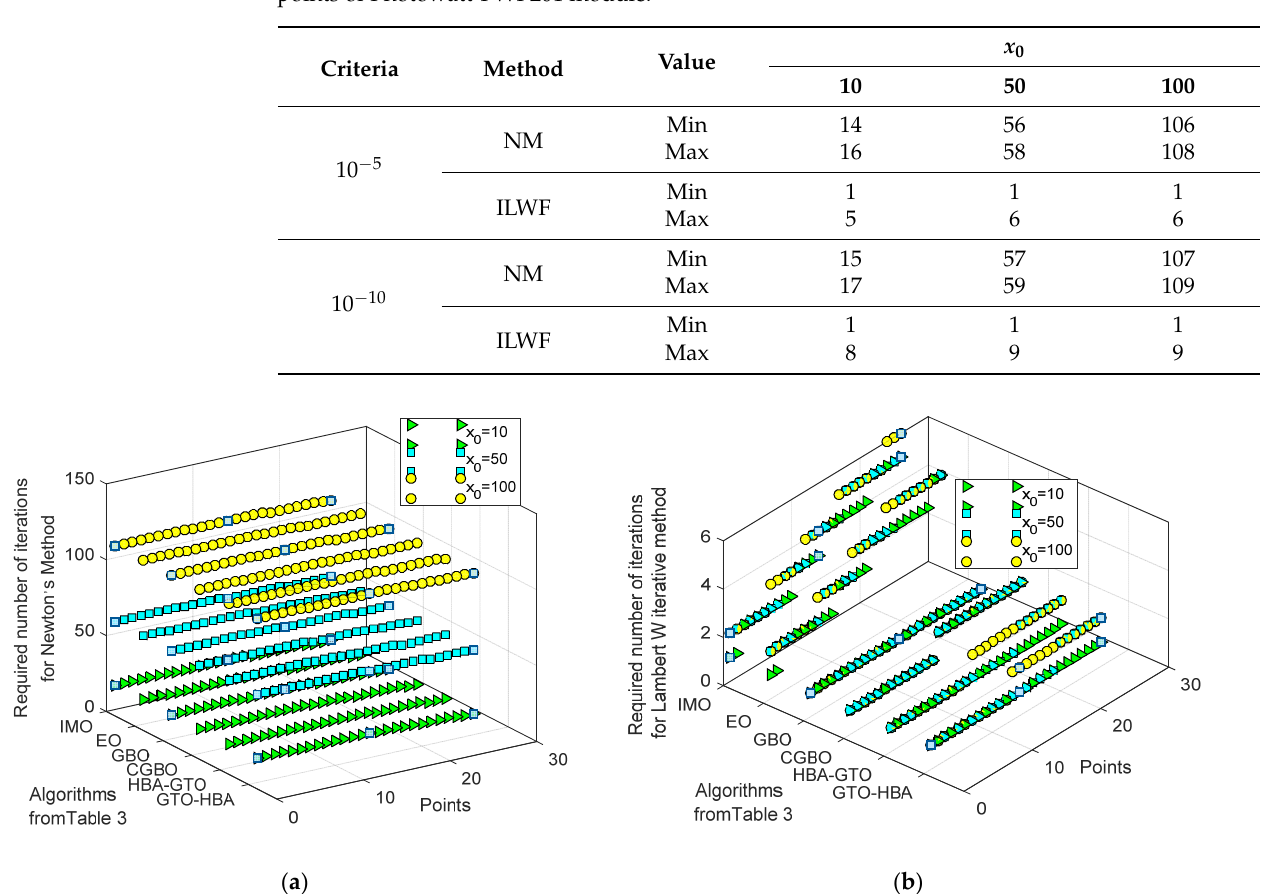
Table 7. Minimum and maximum number of iterations for NM and ILWF observing all the measured points of Photowatt-PWP201 module.